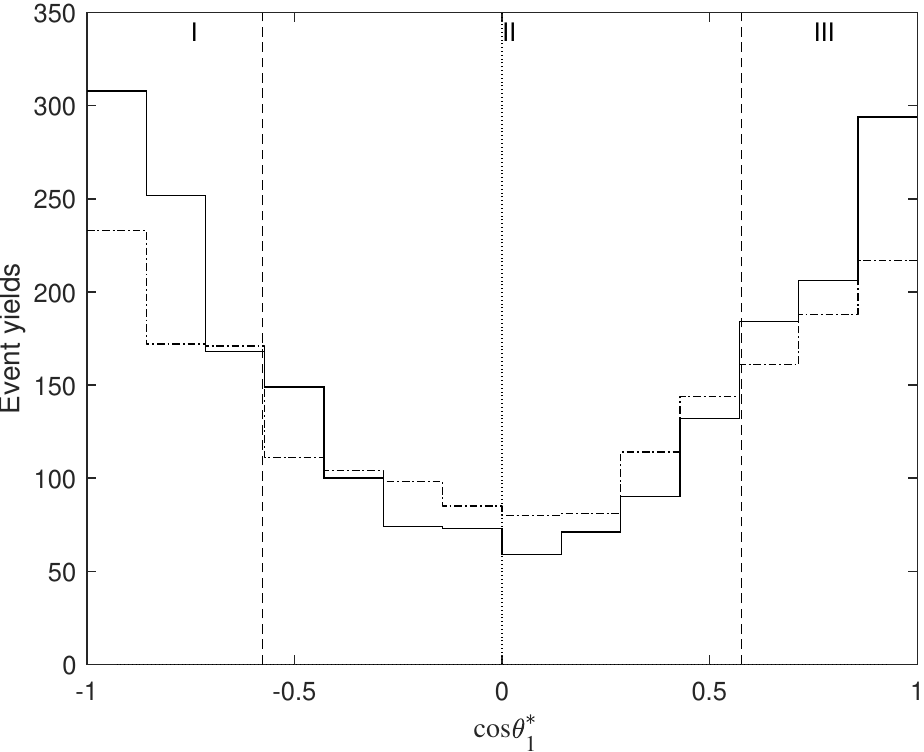
Figure 3 . The simulation of the event yields for δ = 4 . The solid line is for the baryon decay, while the dash-dotted line is for the anti-baryon